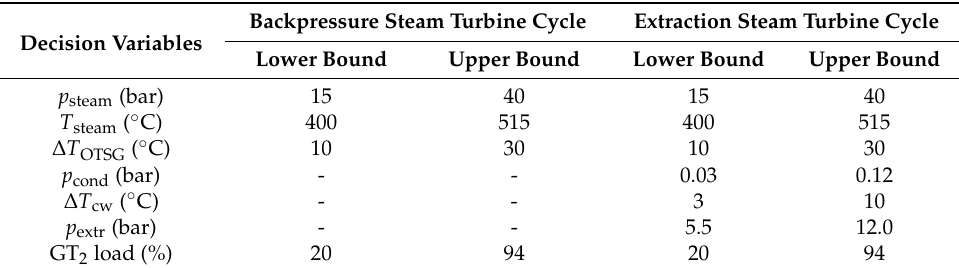
Table 2. List of decision variables, with upper and lower